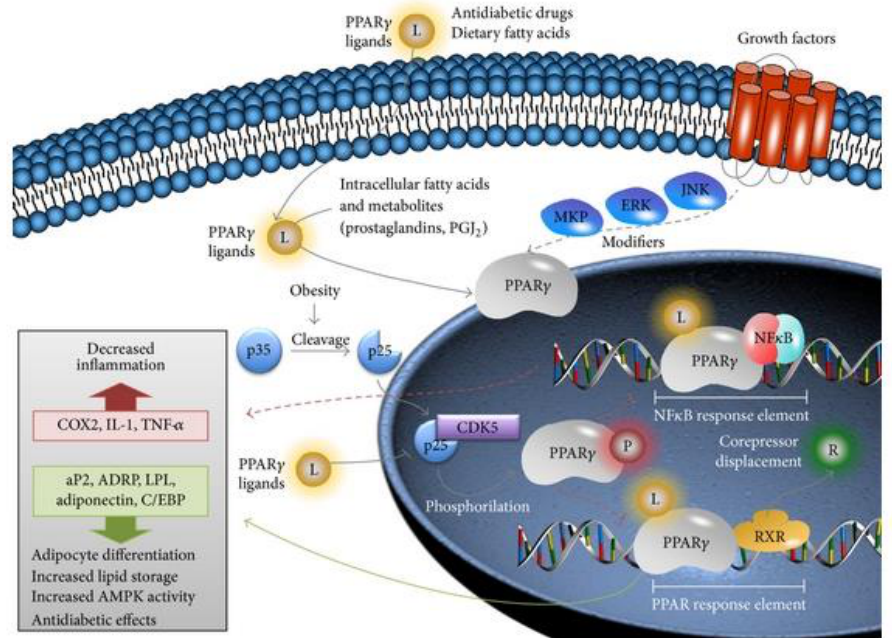
Figure 1. PPAR- γ transduction pathway. PPAR- γ has several extracellular and intracellular ligands that include dietary and bioactive lipids. Given its antidiabetogenic role, some PPAR- γ ligands include antidiabetic drugs such as thiazolidinediones. PPAR- γ is also modulated by several growth factor transduction pathways such as Jnk/Erk/MKP. It is known that the cyclin-dependent kinase 5 (Cdk5) bond to p25 (a product of the cleavage of p35 in an obesity environment) inhibits the PPAR pathway via its phosphorylation. As a transcriptional factor, PPAR binds to RXR (retinol X receptor) to transcribe several genes related to adipocyte differentiation and lipid storage in adipose tissue and that increase insulin sensitivity in peripheral tissues by an indirect increase of AMP kinase activity, as well as several other antidiabetogenic effects. Moreover, PPAR blocks NFB signaling, thus reducing proinflammatory cytokines and inflammation. (https://doi.org/10.1155/2013/401274 (accessed